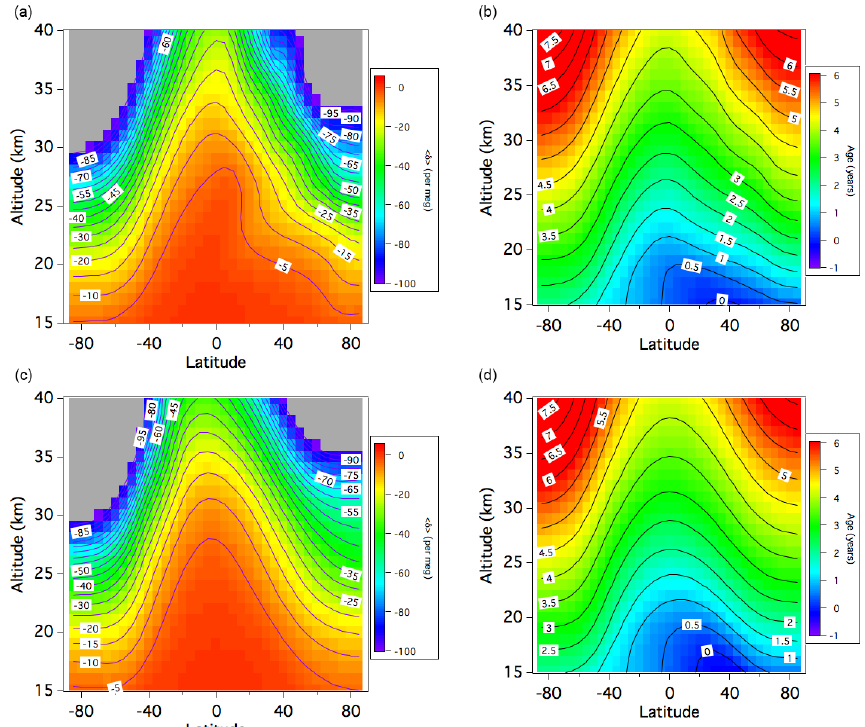
Figure 7. (a) Average meridional distributions of the < δ > value for DJF calculated using the SOCRATES model with the control run (cf. text). The < δ > values lower than − 100 per meg are shown in gray. (b) Same as panel (a) , but for the age of air. (c, d) Same as panels (a) and (b) , but for